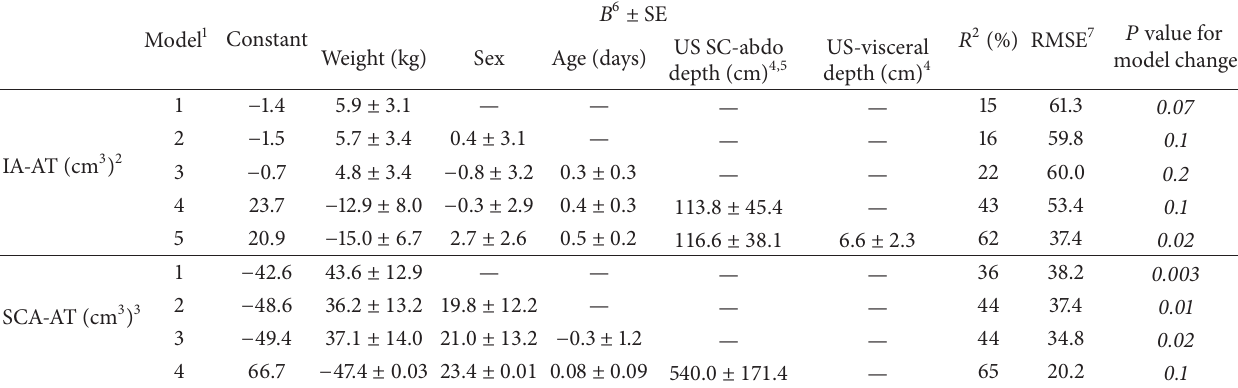
Table 3: Prediction models for IA-AT and SCA-AT in the validation study.